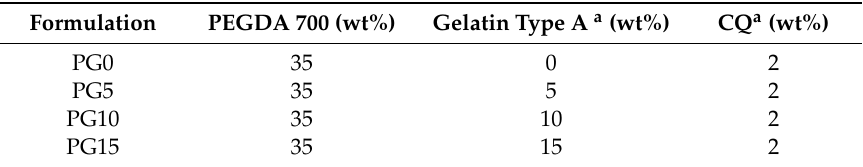
Table 1. Precursor